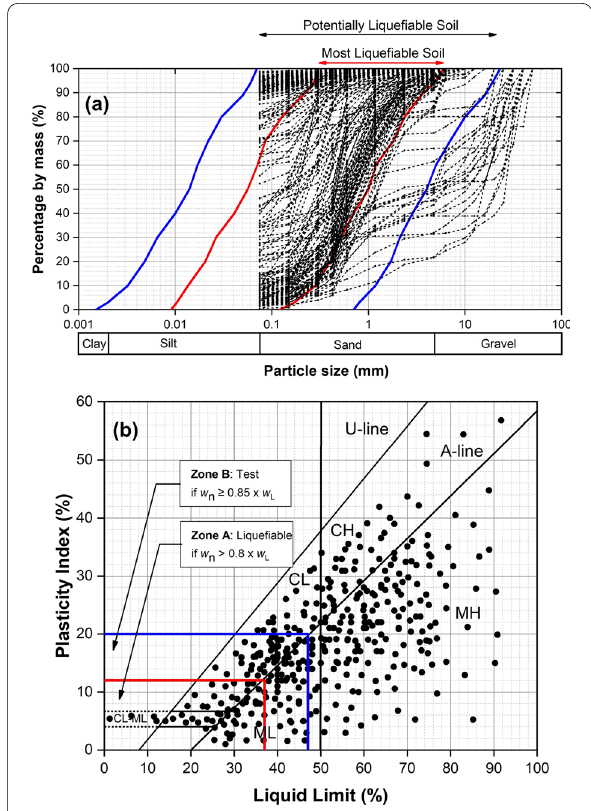
Fig. 5 a Particle size distribution graph of Kathmandu soils with a demarcation of liquefiable soils suggested by Tsuchida and Hayashi (1972), b Casagrande’s plasticity chart with liquefaction criteria given by Seed et al. (2003)